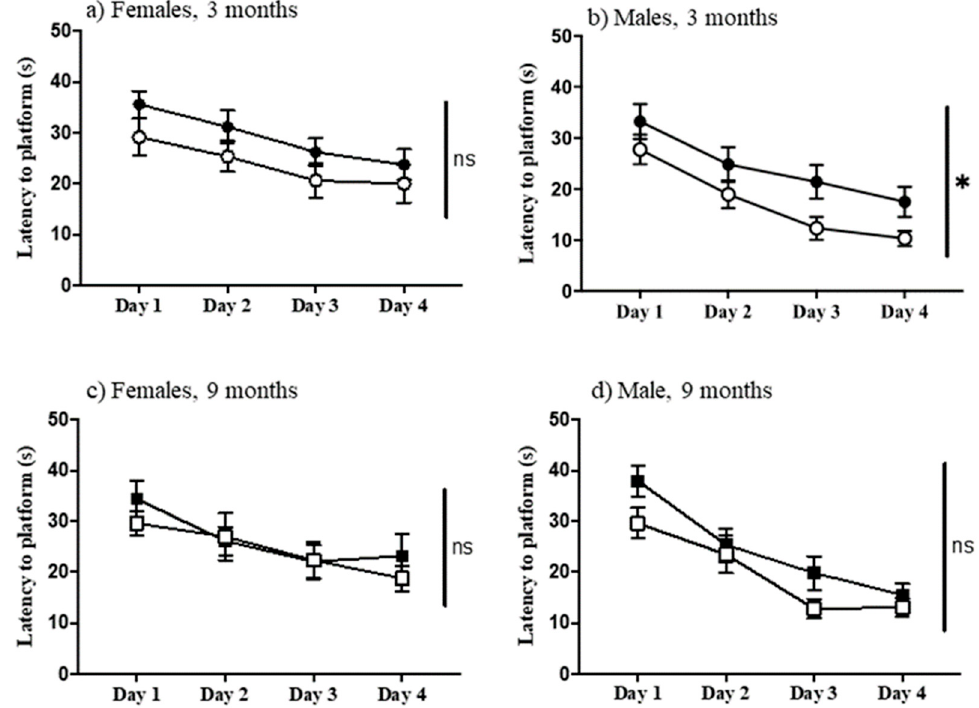
Figure 5. Double-H maze. Latency to reach the platform on successive days. ( a ) Females, 3-month-old; ( b ) Males, 3-month- Figure 5. Double ‐ H maze. Latency to reach the platform on successive days. ( a ) Females, 3 ‐ month ‐ old; ( b ) Males, 3 ‐ month ‐ old; ( c ) Females, 9-month-old; ( d ) Males 9-month-old. Filled circles and boxes, controls; open circles and boxes, Dp10; *, old; ( c ) Females, 9 ‐ month ‐ old; ( d ) Males 9 ‐ month ‐ old. Filled circles and boxes, controls; open circles and boxes, Dp10; *, significant difference; ns, not significant difference; ns, not significant.